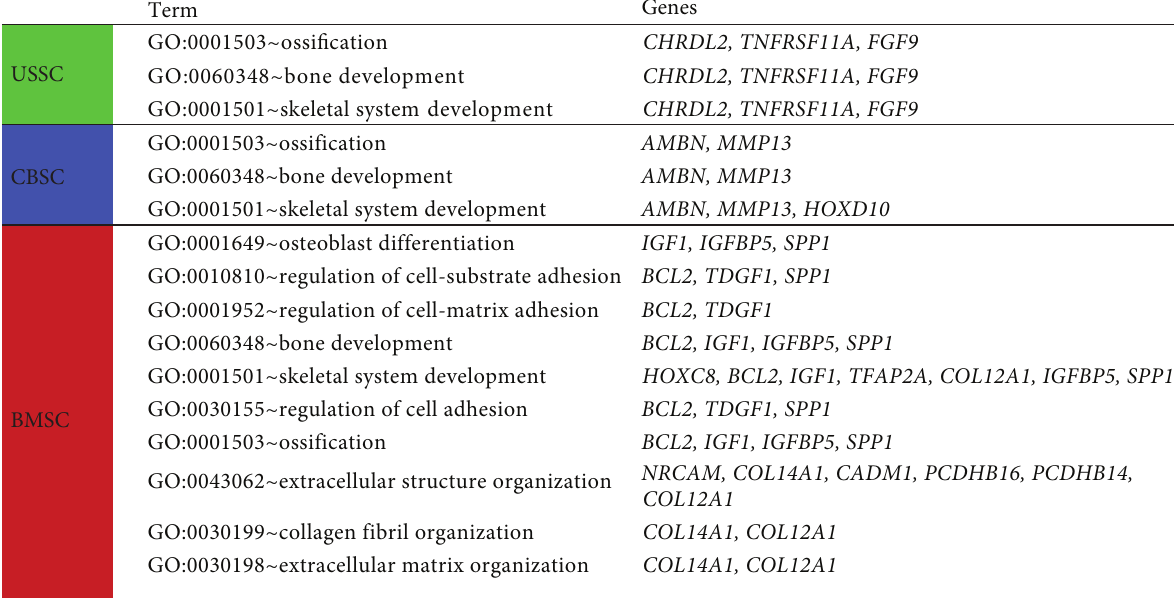
Table 1: Osteogenesis-related genes expressed uniquely in USSC, CBSC, or BMSC. After Venn diagram analyses (Figure 1(a)), the genes expressed uniquely in one cell population (USSC: 304, CBSC: 251, and BMSC: 375) were assigned to gene ontology (GO) terms using the “Functional Annotation Cluster Tool” provided by DAVID Bioinformatics Resources (http://david.abcc.ncifcrf.gov/). Only those GO terms associated with “bone formation” are